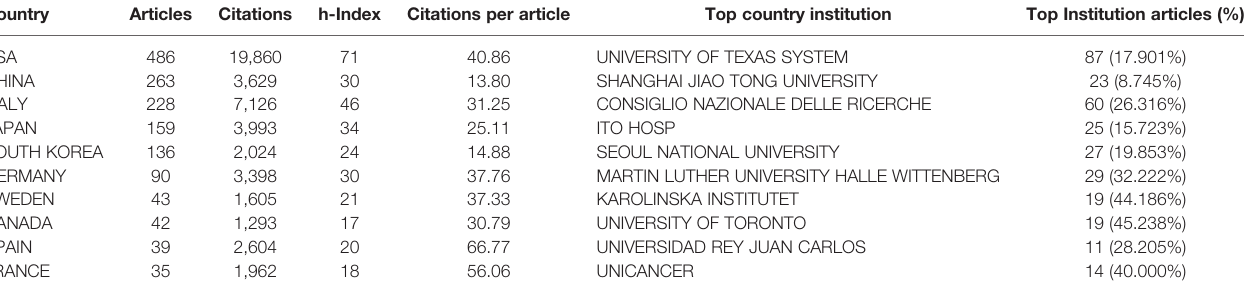
TABLE 1 | Top countries and institutions in ATC fi eld. Country